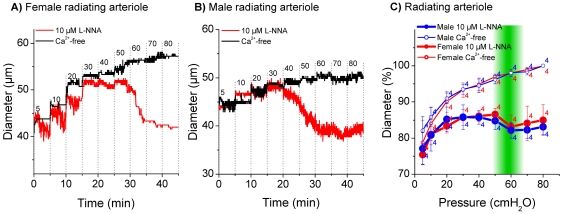
Pressure dependent diameter of female and male radiating arteriole.Original trace of female (A) and male (B) radiating arteriole in 10 µM L-NNA and Ca2+-free solution. Diameter in % in 10 µM L-NNA and Ca2+-free solution (C), % values were normalized to maximal diameter measured in Ca2+-free at 80 cmH2O. 100% = 52.4 µm±3.3 in Ca2+-free at 90 cmH2O in female animals and 53.2 µm±1.7 in Ca2+-free at 90 cmH2O in male animals.